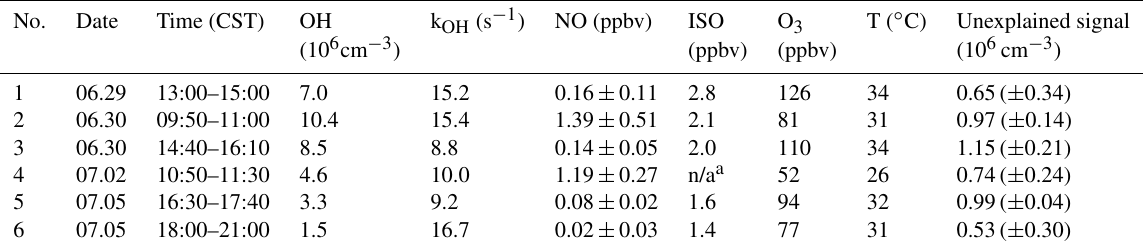
Table 2. Unexplained OH signal and chemical conditions during the OH interference tests. The mean value and the 1 σ standard deviation of the unexplained OH signal are calculated from the differences between S N are expressed as equivalent ambient OH concentrations (see